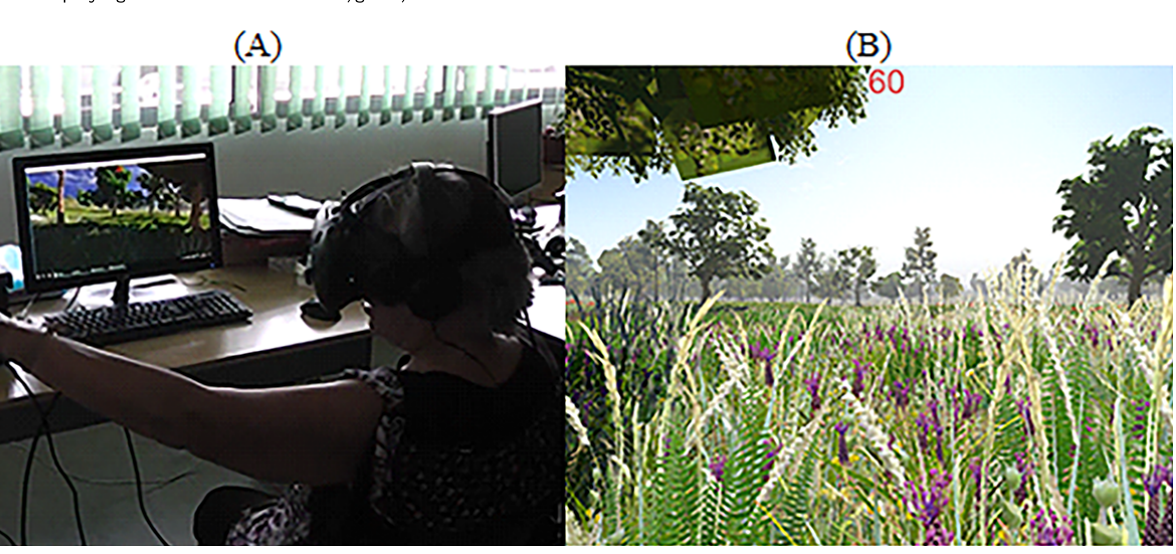
Figure 10. Observing virtual environments: Virtual Forrest. (A) Participants observe a virtual forest using the head-mounted display. (B) Screenshot of the game displaying a virtual forest with trees, grass, and sound.